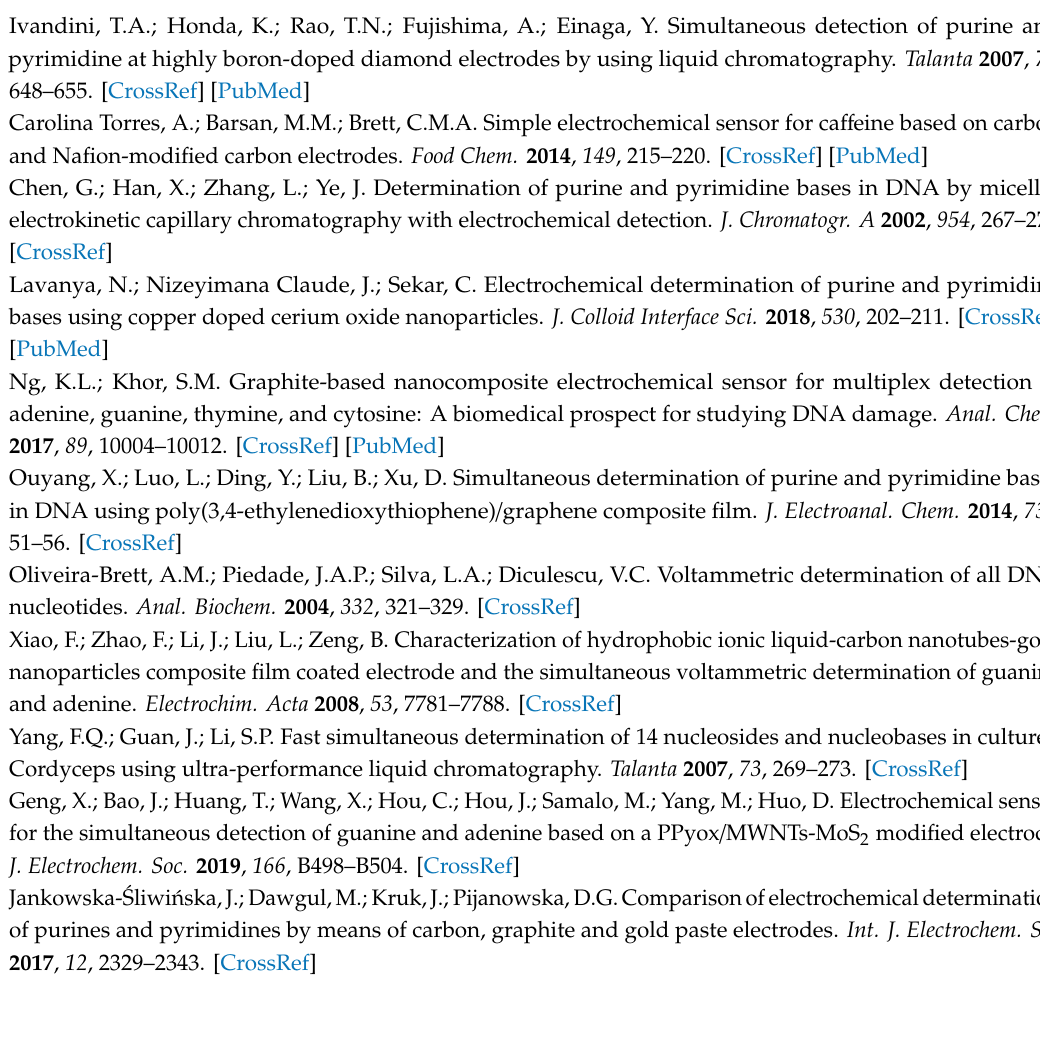
for G detection using chronoamperometry. Figure S9: Linear dependence of square root of time on I c / I L for A detection using chronoamperometry. Figure S10: Linear dependence of square root of time on I c / I L for T detection using chronoamperometry. Figure S11: Linear dependence of square root of time on I c / I L for C detection using chronoamperometry. Figure S12: DPV for standard addition in human serum sample that was diluted 10-fold in 0.2 M PBS (pH 7.0). Figure S13: DPV for standard addition in human saliva sample that was diluted 5-fold in 0.2 M PBS (pH 7.0). Figure S14: DPV for standard addition in artificial saliva sample that was diluted 5-fold in 0.2 M PBS (pH 7.0). Table S1: A summary of calculated di ff usion coe ffi cients, catalytic rate constants and heterogeneous kinetic rate constant (K h ) for UA, G, A, T and C using the designated electrode. Table S2: Comparison table of classical methods for DNA detection and the proposed electrochemical